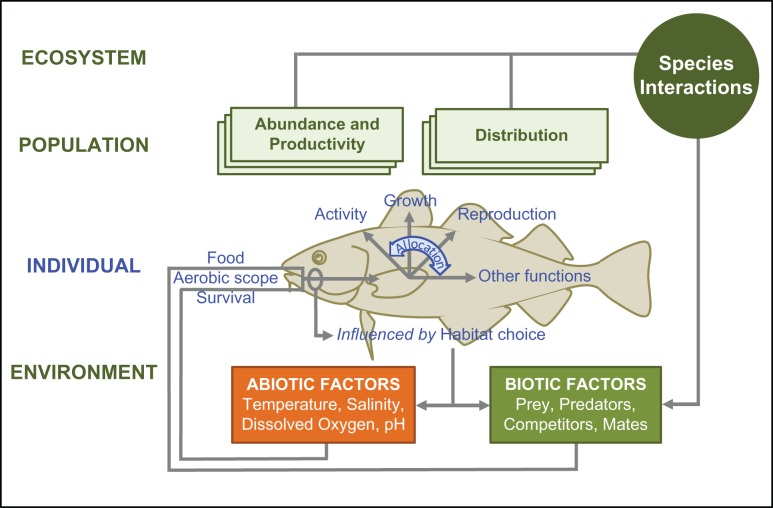
A schematic diagram of how aerobic scope can be integrated into mechanistically based models. It can be used to form a performance curve with temperature, to describe habitat suitability (metabolic maps, e.g. Marras et al., 2015a) and it can be a constraint for oxygen allocation to competing activities in life-history models (Holt and Jørgensen, 2014, 2015). See Jørgensen et al. (2012) for more details.